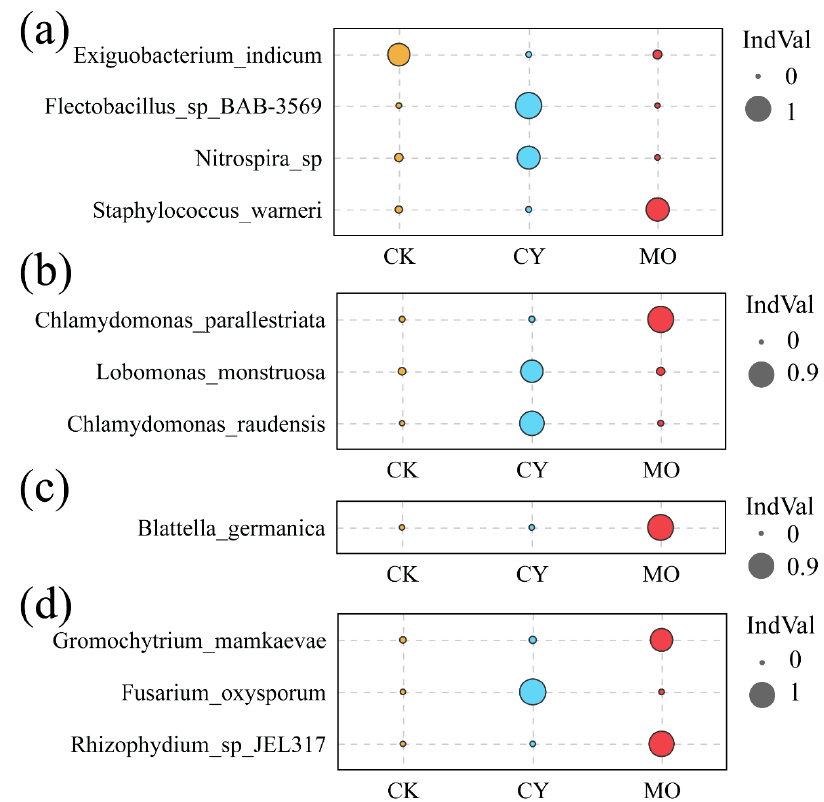
Figure 3. Indicator species of ( a ) bacteria, ( b ) phytoplankton, ( c ) zooplankton, and ( d ) fungi in each group.